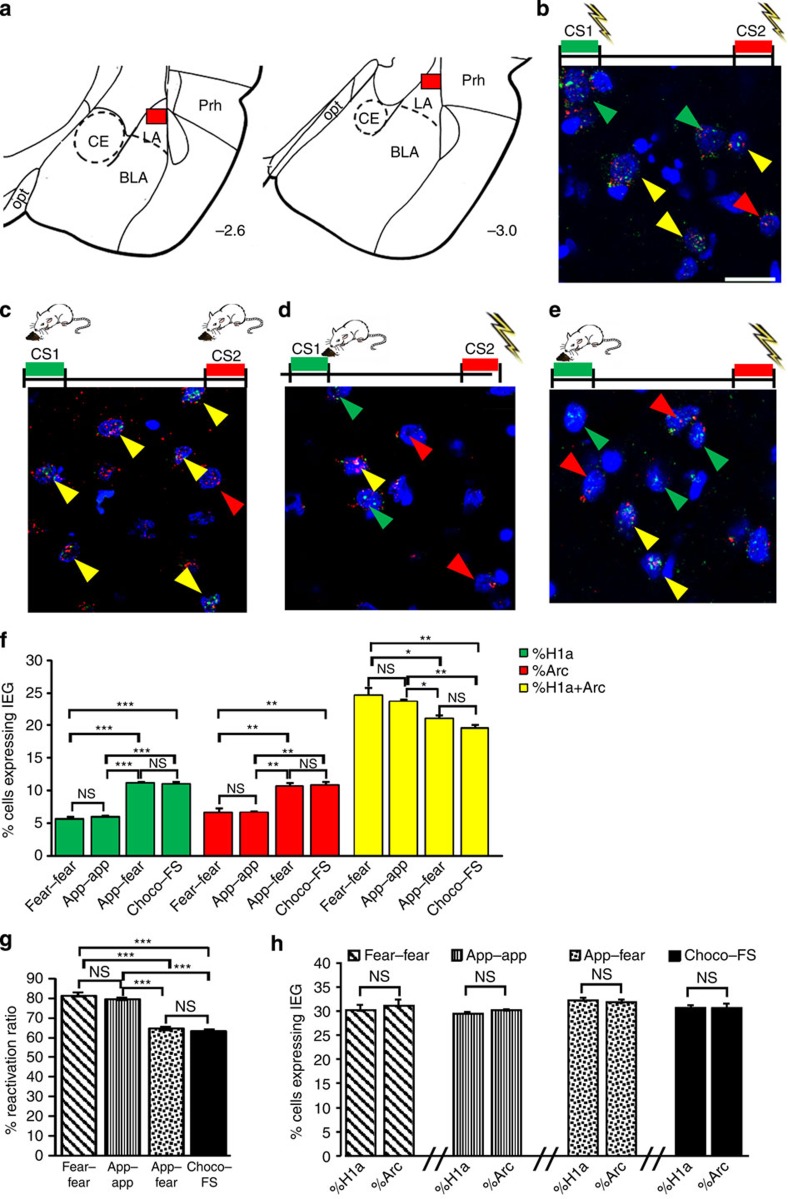
Anatomically distinct neurons in the lateral amygdala reflect emotionally charged unconditioned and learned stimuli.(a) catFISH analysis was performed in the lateral region of the amygdala (lateral amygdala). Plates adapted from the Zilles atlas53. BLA, basal lateral amygdala; CE, central amygdala; Opt, optic tract; PRh, perirhinal cortex. (b,e) Representative fluorescent photomicrographs showing neurons expressing H1a (green arrows) or Arc (red arrows) or both (yellow arrows) in fear–fear (n=5) (b), appetitive-appetitive (n=6) (app–app) (c), appetitive–fear (n=4) (d) conditioned groups and in rats that received an unconditioned stimuli (n=6) (chocolate-foot shock, choco-FS) (e). Scale bar, 20 μm. (f) Percentages of cells expressing only H1a or Arc or both genes in the four behavioural groups. One-way ANOVA revealed differences among groups in the percentages of H1a (F(3,17)=65.84, P<0.001), Arc (F(3,17)=16.9, P<0.001), and doubly labelled cells (F(3,17)=10.93, P<0.001). Newman–Keuls test showed that appetitive–fear and unconditioned-treated animals did not differ from each other (P>0.05 in all instances, NS) while they were different from both the fear–fear and app-app groups. In the same way, the fear–fear and app-app groups did not differ from each other in all instances (P>0.05, NS). (g) Both appetitive–fear and unconditioned-treated animals had lower reactivation ratios than the fear–fear and app–app groups (F(3,17)=72.81, P<0.001). (h) In each group, the percentage of H1a-positive cells was similar to that of Arc-positive cells (fear–fear, t8= 0.55, NS; app-app, t10=1.37, NS; appetitive–fear, t6=−0.40, NS; unconditioned treated rats, t10=−0.24, NS). *P<0.05; **P<0.01, ***P<0.001; NS, not significant.